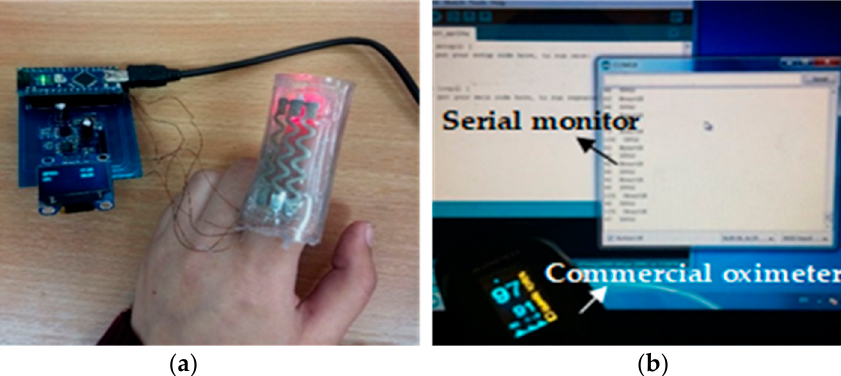
Figure 20. Functional stretchable pulse oximeter. ( a ) The stretchable pulse oximeter is interfaced with external circuitry; ( b ) data is collected by the sensor displayed on Arduino serial monitor and sensor output is compared to a commercial pulse oximeter.